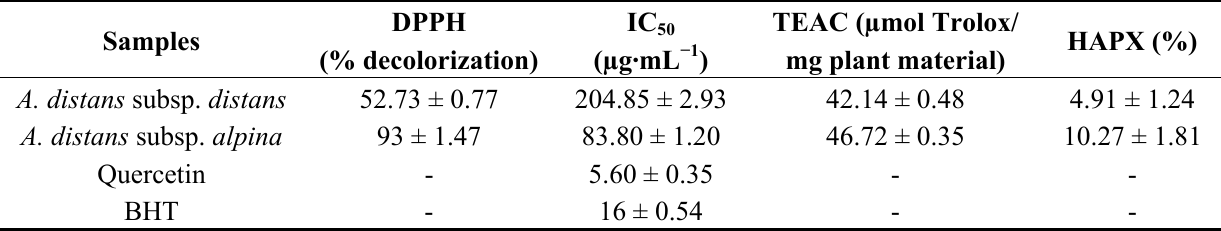
Table 4. Antioxidant capacity parameters obtained using several methods for studied Achillea